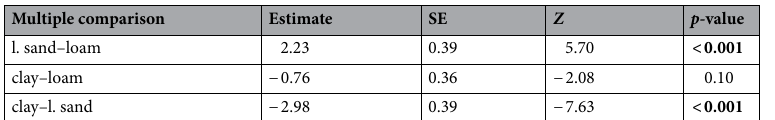
Table 2. Multiple comparison between soil types of the pupated pupae. Test: Tukey Honest Significant Difference. Significant values are in bold.